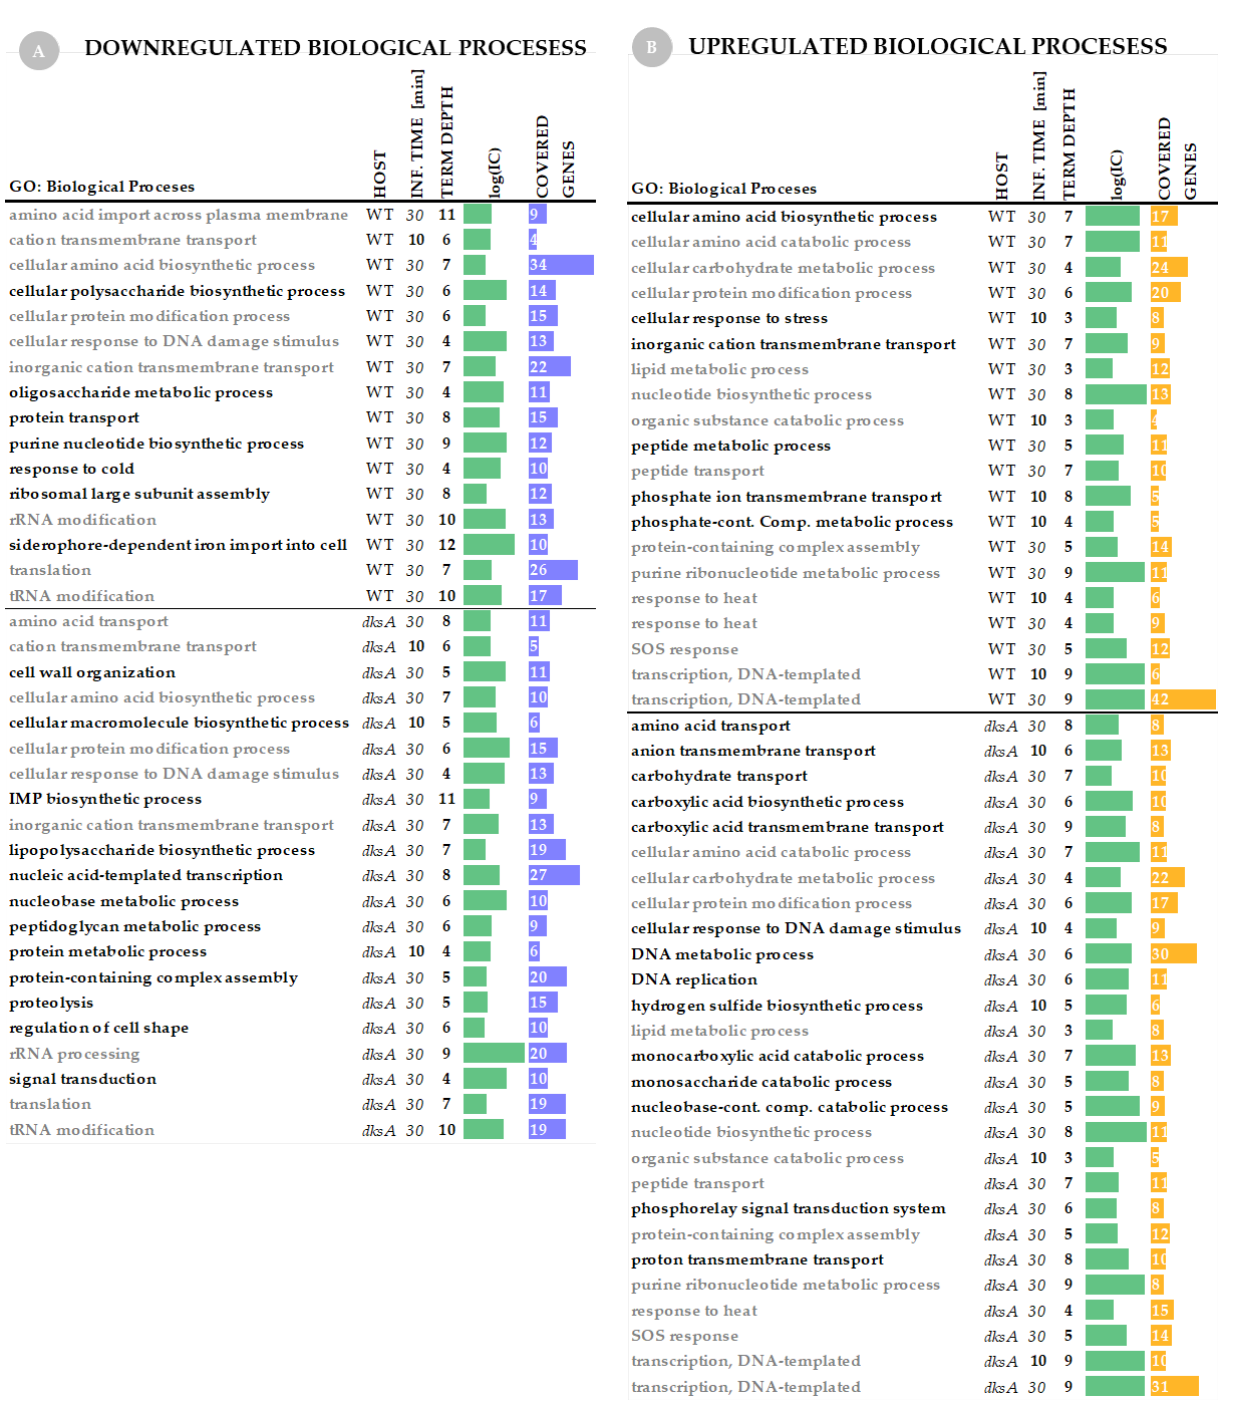
Figure 4. Gene Ontology (GO) terms analysis of the host genes upon P1 vir infection. Panel ( A ) shows downregulated biological processes in the wild-type strain and the dksA mutant. Panel ( B ) shows upregulated biological processes in both tested hosts. The horizontal line indicates a border between the host sets of GO terms. Descriptions in gray represent GO terms that are common to both hosts. Descriptions in black represent biological processes that are uniquely up- or downregulated in a given host. We used the GSAn algorithm exploiting the semantic of concepts in Gene Ontology which provided a reduced and synthetic number of GO terms resuming the biological role of the gene set input. The Information Content (IC) is a score associated with the terms explaining how much they are informative (the bigger the IC is, the more specific the term is); log(IC) is used for visualization purposes. Term depth (number of GO terms united together after semantic analysis) and covered genes (the number of genes whose expression has been up- or downregulated) are also